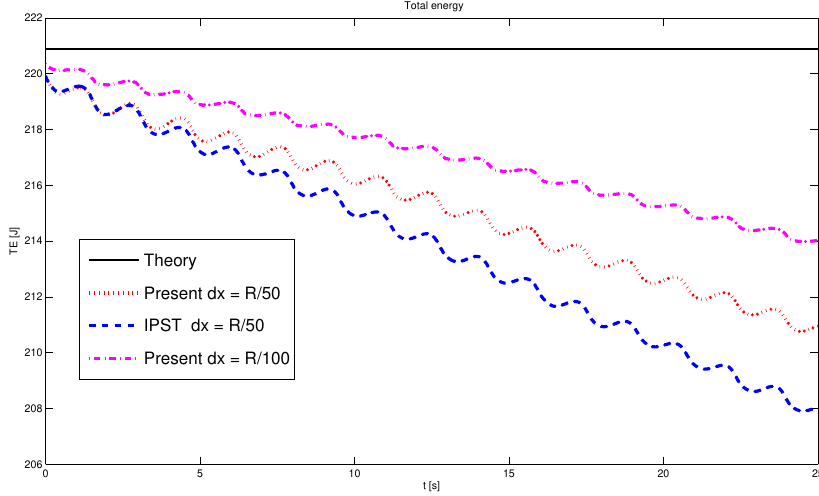
Figure 12. Oscillating droplet under a central conservative force field: Total energy evolution in time E T ( t ) . The black solid line presents the theoretical results obtained by solving the system (18) [60]. The red dotted line represents the results obtained by the present particle shifting formulation for the fluid droplet of resolution dx = R , whereas for the magenta dash-dot line is for dx = R 50 dashed line represents the results obtained by the particle shifting technology (IPST) proposed by Wang et al. [37].